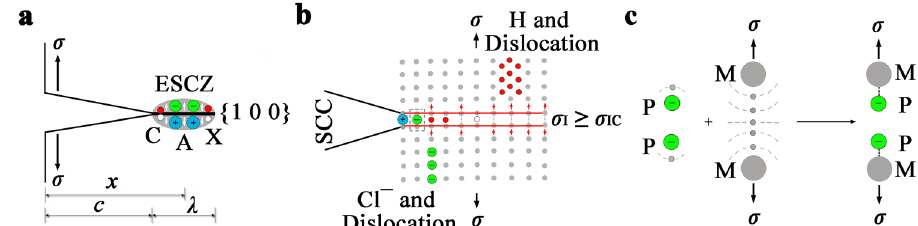
Fig. 4 An atomic-scale brittle rupture and dislocation pinning model. a In the ESCZ, cations, anions, hydrogen atoms, and vacancies are marked by green, blue, red, and white circles, respectively. b The SCC advance along the corrosive environment particle adsorbed low-surface- energy cleavage planes such as {1 0 0} on σ I ≥ σ IC , and the intrinsic dislocations in the ESCZ are pinned by the hydrogen atoms and the electronegative ions such as the chlorine ions. c The chemical and physical interactions between the metal atoms on the cleavage planes and the microscopic corrosive particles, P , such as the electronegative ions, marked by the dotted rectangle in ( b corresponding slip system is prevented to be triggered, which increases the critical shear stress and the resistance of the dislocation slipping 24,25 . For instance, the hydrogen atoms are able to weaken the pair interactions between the coplanar dislocations 18,20 , and lower the effective speed, at which the dislocation loop shrinks 25 . Similarly, the other solute atoms can also pin the dislocations and prohibit the dislocation motion through the formation of the Cottrell or Snoek atmospheres. To sum up, the pinning of the dislocations by the corrosive environment particles leads to the embrittlement of the ESCZs in the ductile metal crystals. Further, the electronegative ions, the hydrogen atoms, and the vacancies are interacted with the metal atoms of the cleavage planes in the ESCZs, shown in Fig. 4b, c. For instance, the 1s orbital electrons of the hydrogen atoms are generally migrated to the metal atom orbital ‘ d ’ , so the metal atoms are full of electrons and become saturated 23,35 . To some extent, the electron